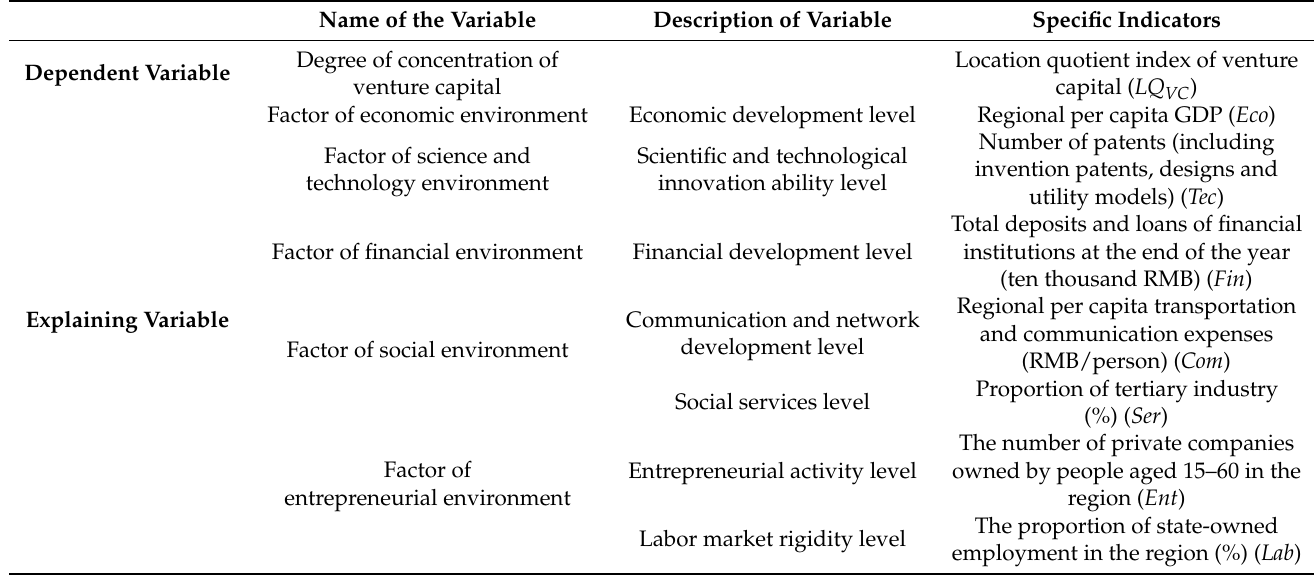
Table 1. Variable definition and